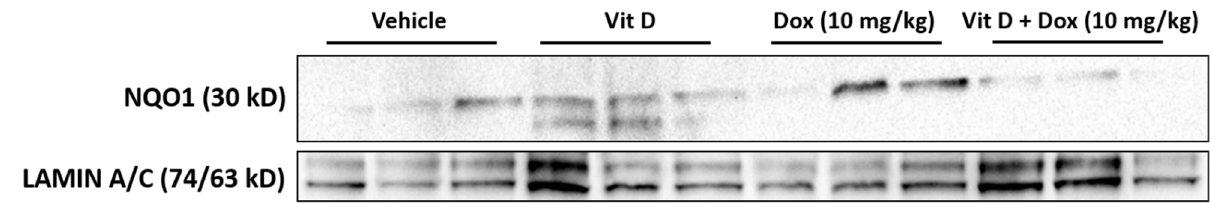
Figure 4. Immunoblot for NAD(P)H quinone oxidoreductase (NQO1) expression in mouse cardiac tissue. LAMIN A/C was the loading control. NQO1 expression was lower in mice treated with vitamin D + Dox (10 mg/kg) vs. Dox (10 mg/kg). Each lane represents the results for one mouse; three mice per experimental group were analyzed.